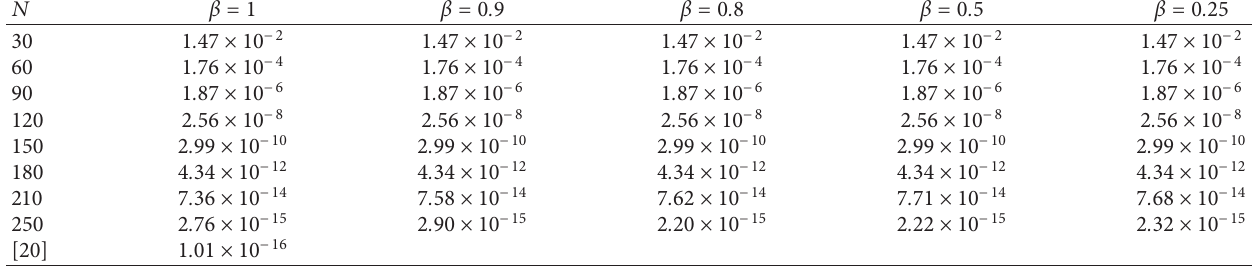
Table 2: The absolute errors obtained for different fractional orders β and N at x � 1.